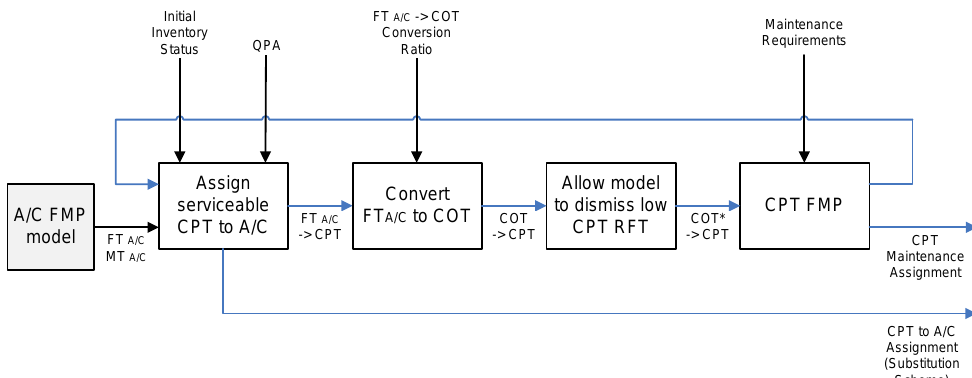
Figure 4. Representation of the CMP model flow, inputs and outputs.